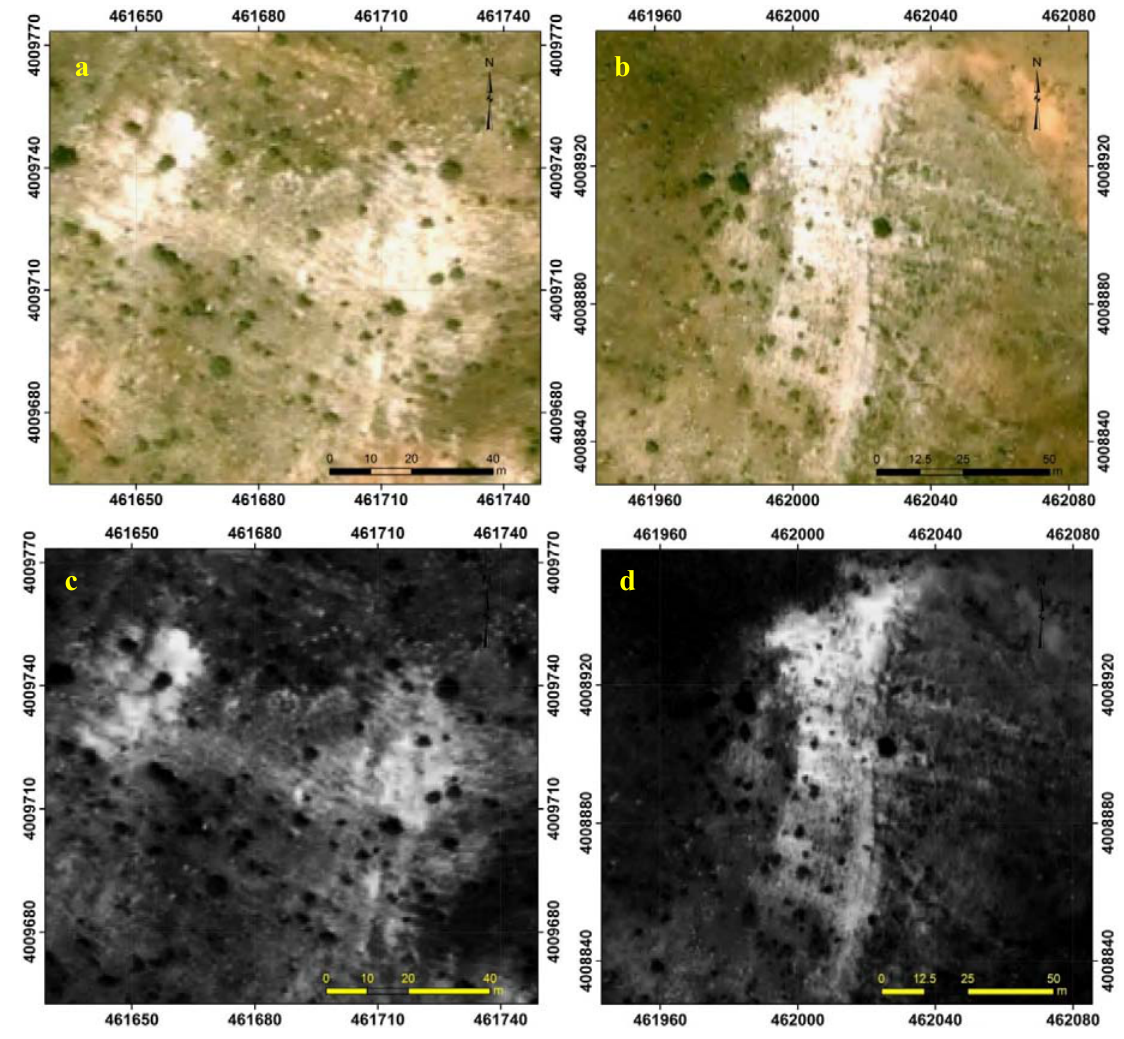
Figure 12. Typical examples of automatic landslide extraction: ( a , b ) landslides in QuickBird image represent S8 and S7, respectively ( c , d ) brightness indicator ( e , f ) relation between shape file, which extracted from the brightness indicator with DN number >84 and slope >10° and manual extraction of